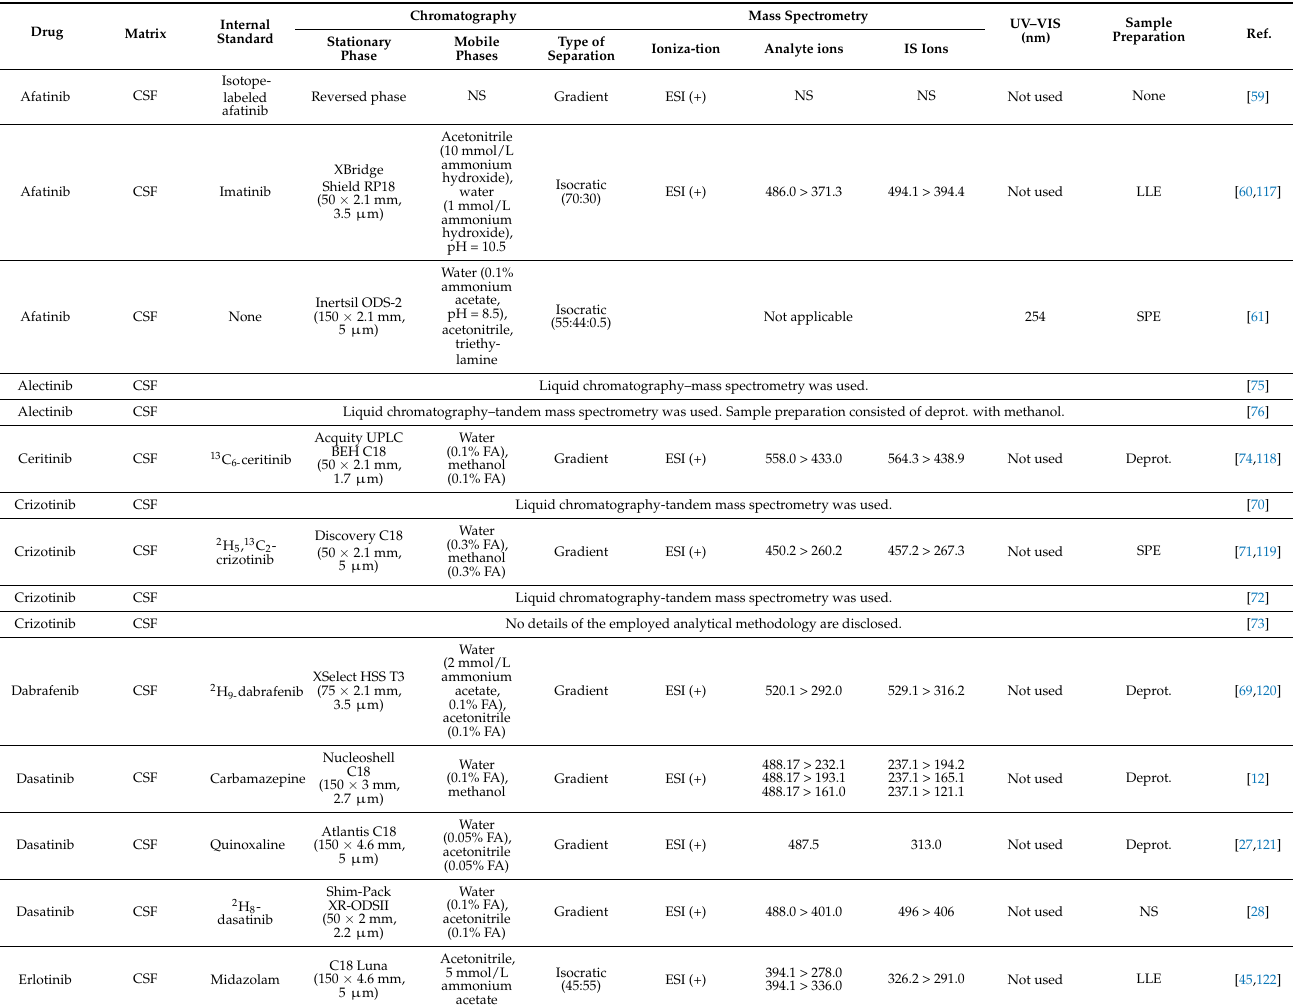
Table 4. Analytical approaches to monitoring the concentrations of orally administered, small- molecule anticancer medications with tumor-specific cellular protein targets in peripheral fluid spaces. CSF, cerebrospinal fluid; Deprot., deproteinization; FA, formic acid; IS, internal standard; LLE, liquid–liquid extraction; NS, not specified; PBMC, peripheral blood mononuclear cells; SPE, solid phase extraction; TFA, trifluoroacetic acid.